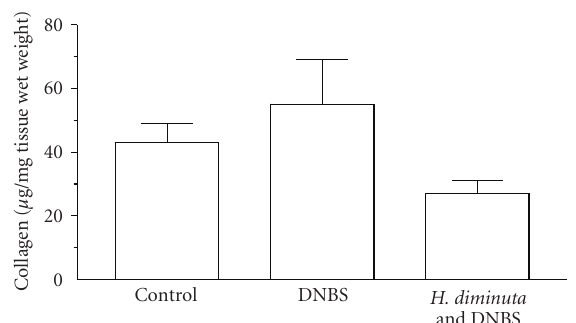
Figure 4: Bar graph showing the amount of collagen deposition in the colon of control, DNBS (ir, 2.5mg) and H. diminuta- infected (5 cysticercoids, 8 days prior to DNBS) + DNBS treated mice (mean ± SEM; n =